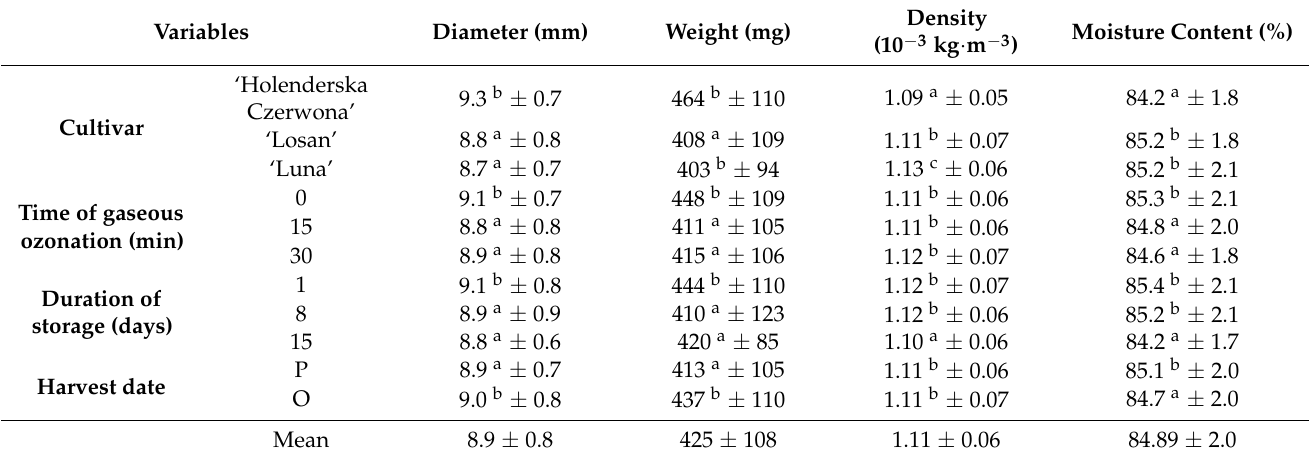
Table 1. Morphological features and moisture content of red currant fruits depending on the variety, duration of storage, and time of gaseous ozonation.